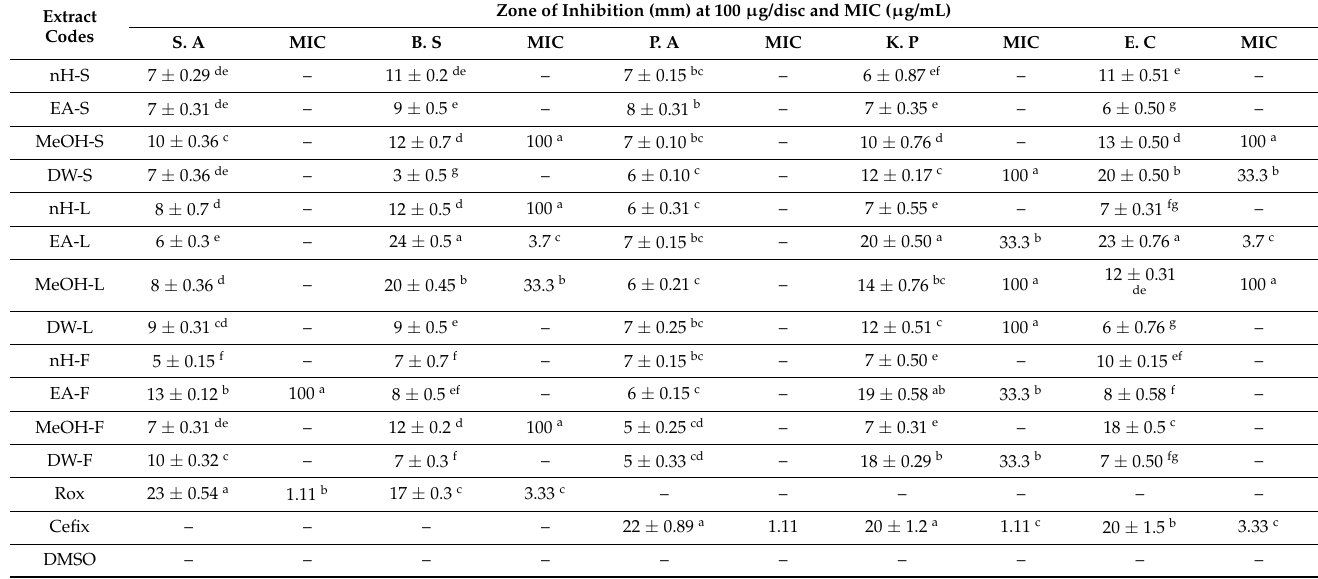
Table 2. Antibacterial activity and MIC values of P. roxburghii test